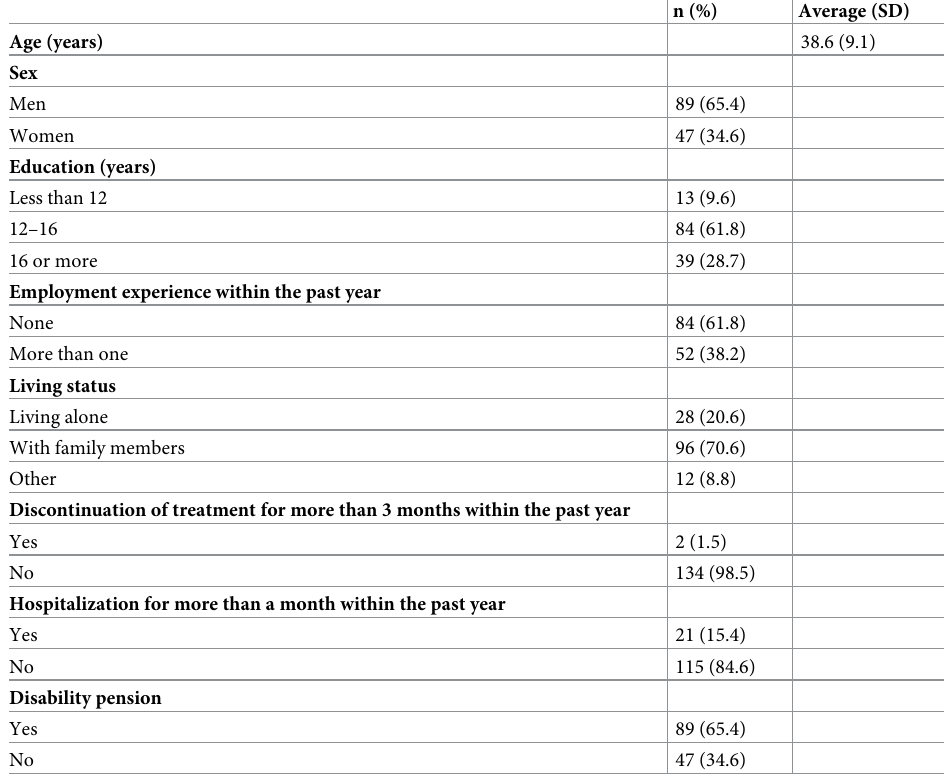
Table 1. Baseline demographic characteristics (N =